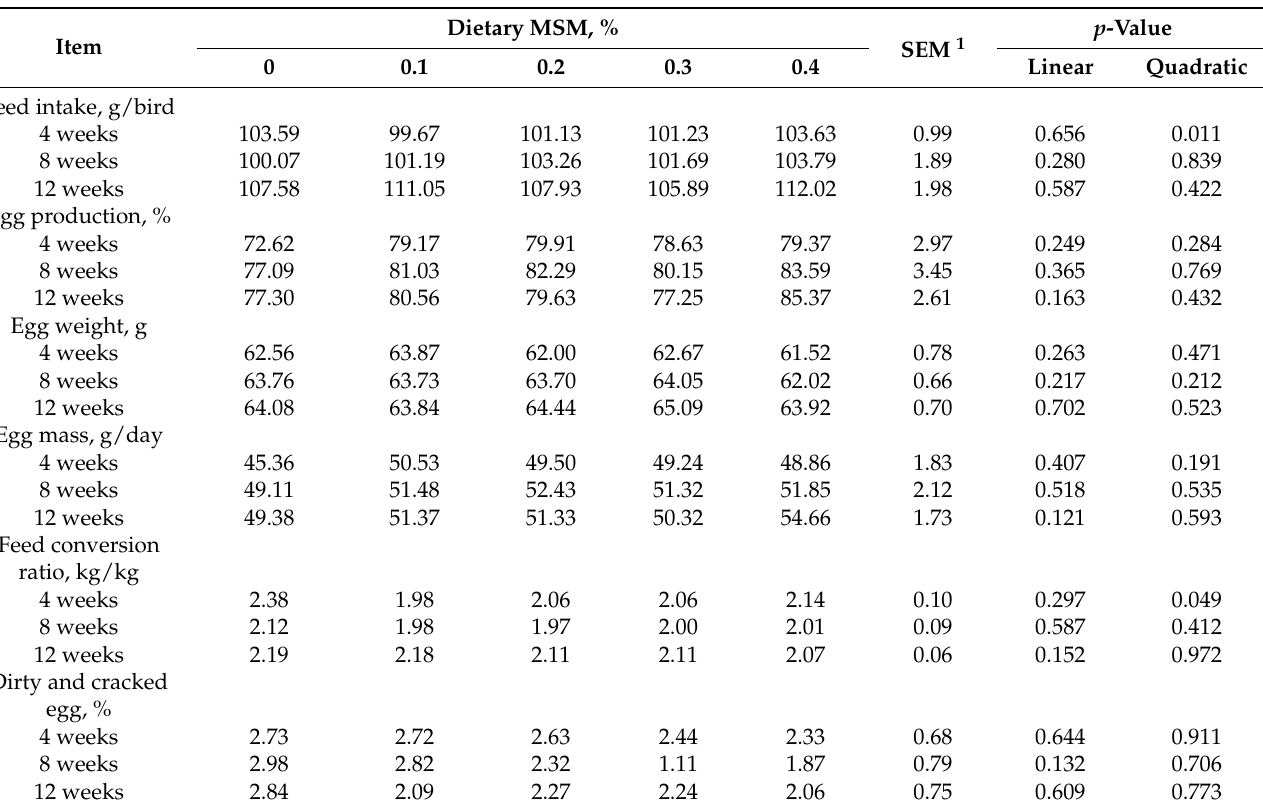
Table 2. Effects of graded levels of dietary methyl sulfonyl methane on the laying performance of laying hens.